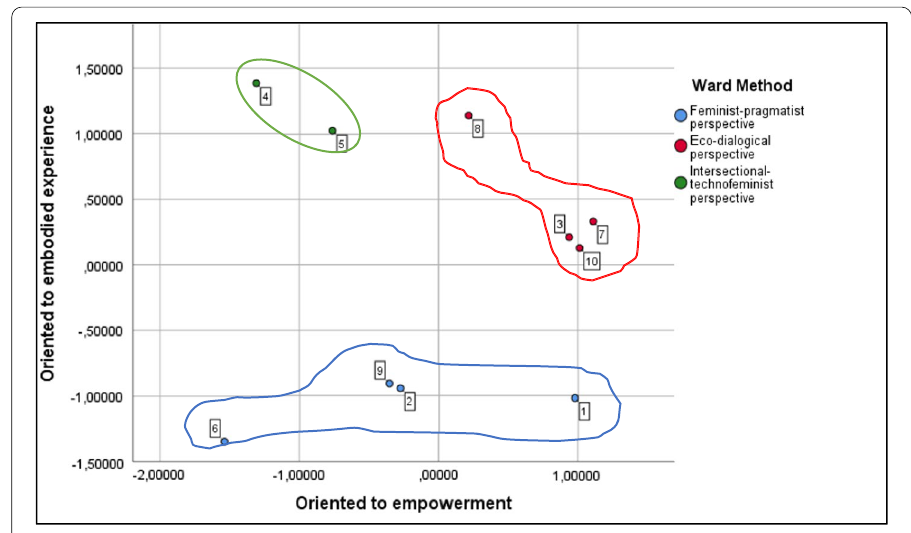
Fig. 3 Cluster dispersion and cases